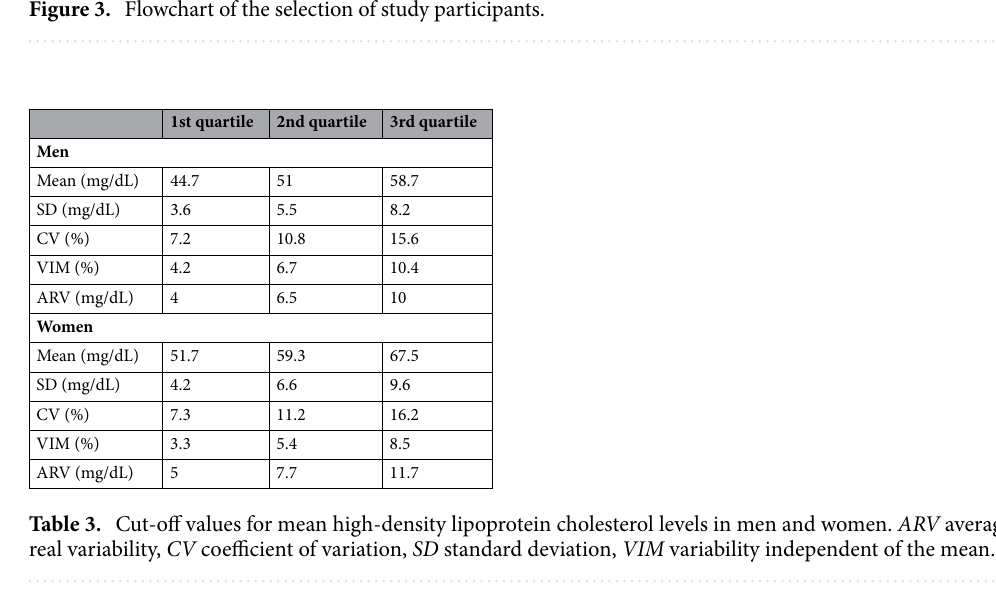
Figure 3. Flowchart of the selection of study participants.